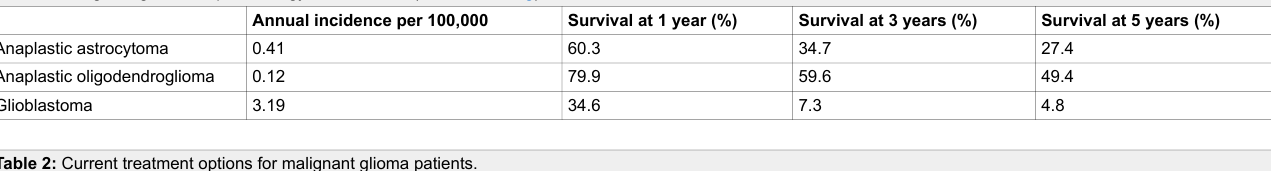
Table 2: Current treatment options for malignant glioma